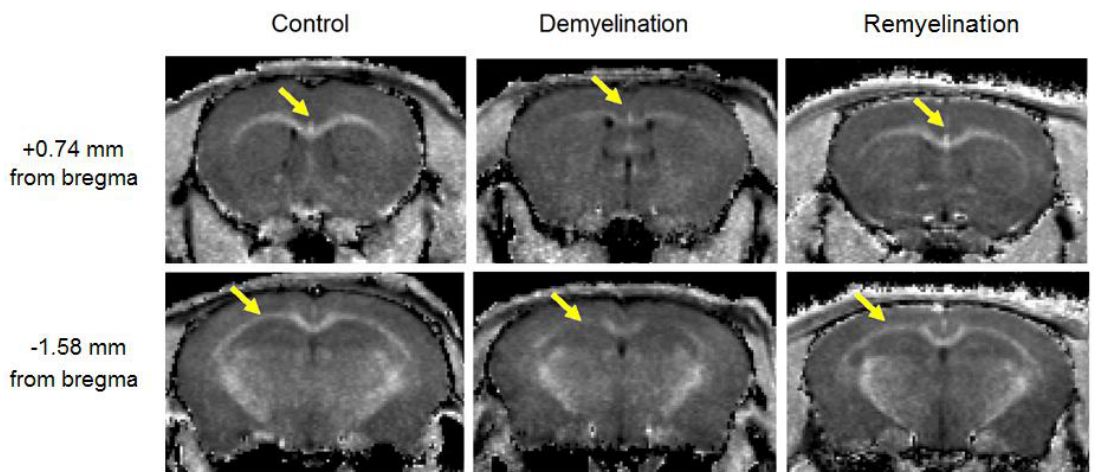
Figure 2. Example MPF maps of the mice from the control (left), demyelination (center), and remyelination (right) groups. Cross-sections of 3D MPF maps were taken through the caudate putamen ( + 0.74 mm from bregma, top) and hippocampus ( − 1.58 mm from bregma, bottom). Arrows show a visible reduction in MPF in the corpus callosum. MPF maps are presented with the grayscale range corresponding to 2–16% and window centered at 9%.